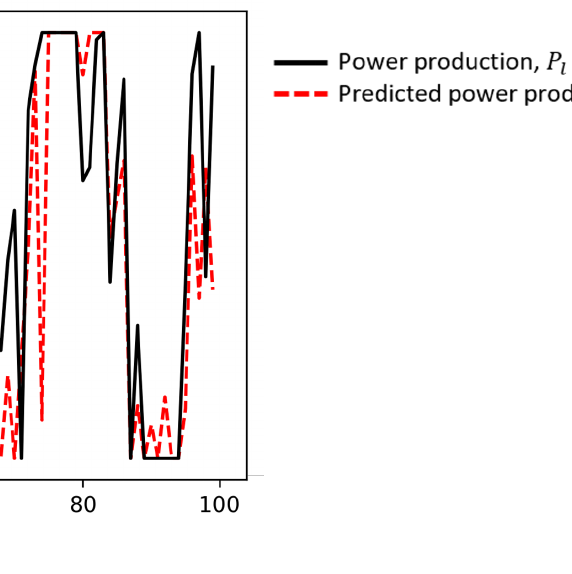
Figure 3. Comparison between true and predicted power production.